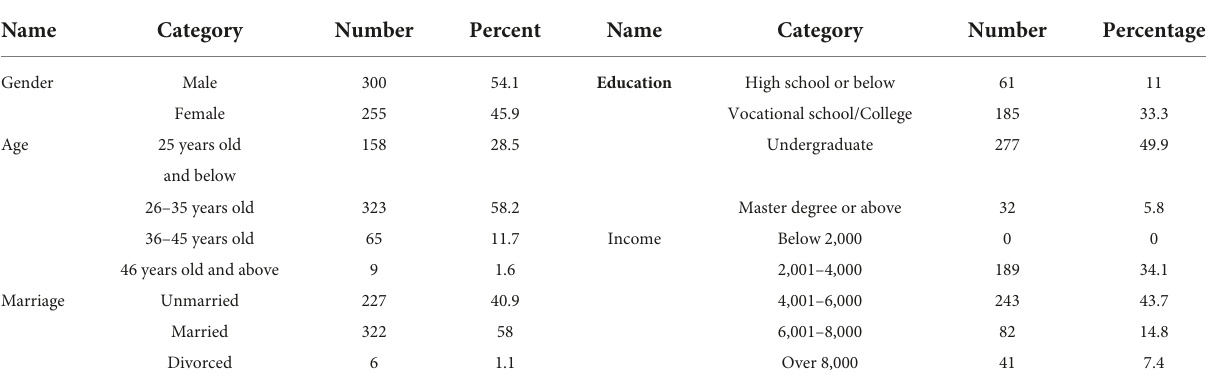
TABLE 1 Composition of valid